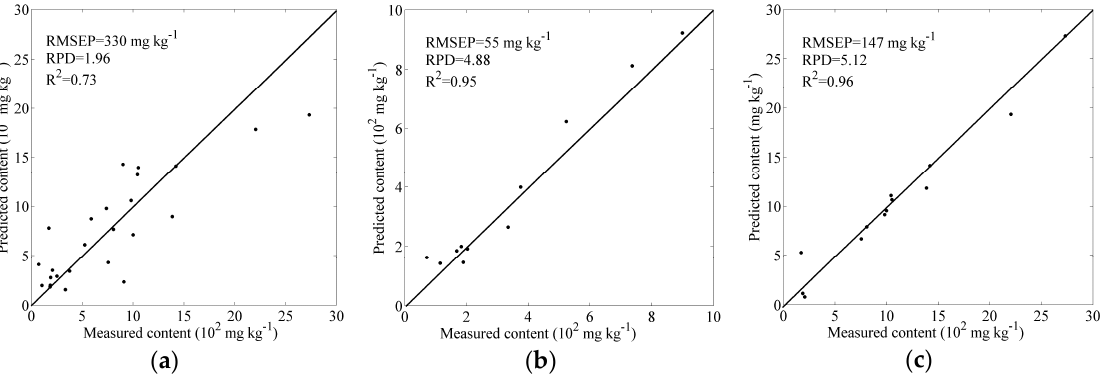
Figure 9. Scatter plot of the measured against predicted Zn concentrations: ( a ) scatter plots of the selected subset of the 74 soil samples, and ( b , c ) scatter plots of Group DE1 and DE2, respectively.